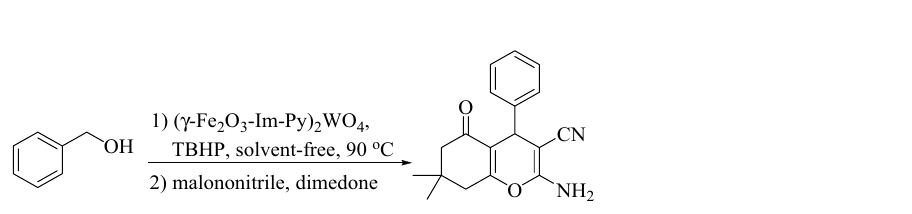
Figure 9. Synthesis of 2-amino-3-cyano-4 H -chromenes via multicomponent TOP from benzyl alcohol using different amounts of the catalyst.